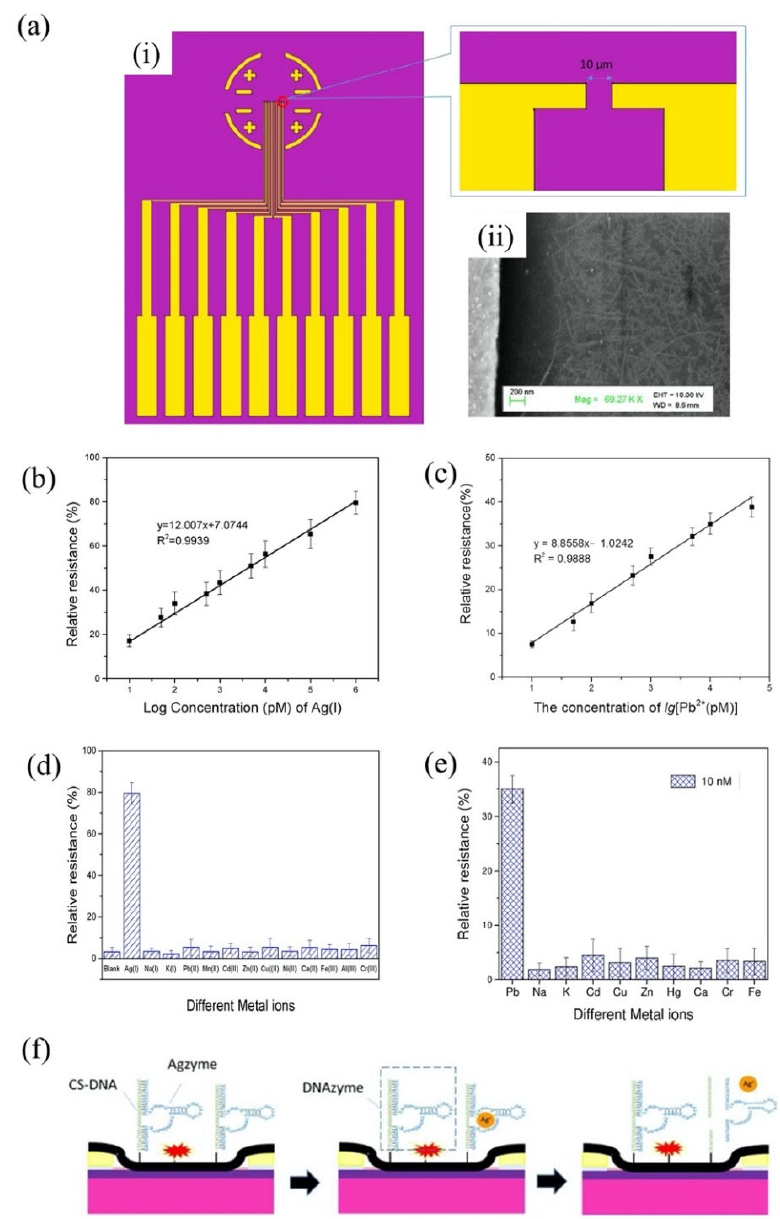
Figure 6. DNAzyme/SWCNTs/FET device proposed by Wang et al. ( a ‐ i ) There are five FET devices on a chip. The size of each channel width was 10 μ m (a ‐ ii) SEM image of SWCNTs FET. ( b ) The linearity response of the Agzyme/SWCNTs/FET with increasing Ag + concentration. Reproduced with permission from [120]. Copyright 2018 MDPI. ( c ) The linearity response of the Pbzyme/SWCNTs/FET with increasing Pb 2+ concentration. Reprinted with permission from reference [121]. Copyright 2019 John Wiley and Sons. ( d ) Selectivity performance of Agzyme/SWCNTs/FET in interference ions solutions. Reproduced with permission from [120]. Copyright 2018 MDPI. ( e ) Selectivity performance of Pbzyme/SWCNTs/FET in interference ions solutions. Reprinted with permission from reference [121]. Copyright 2019 John Wiley and Sons. ( f ) DNAzyme cleaves its substrate strand at RNA site in the presence of HMIs. Reproduced with permission from [120]. Copyright 2018 MDPI.